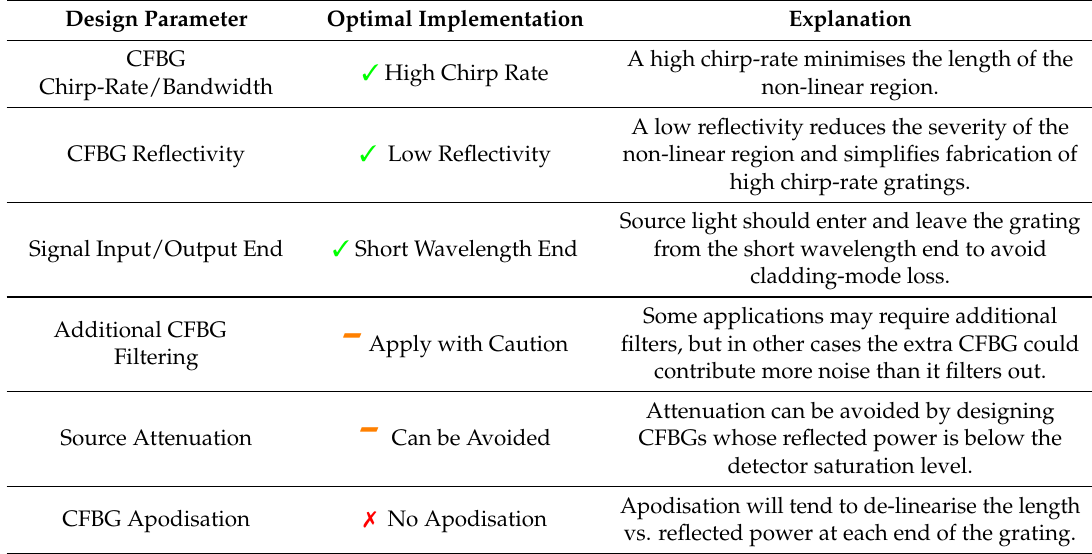
Table 4. A summary of design considerations for CFBG detonation velocity